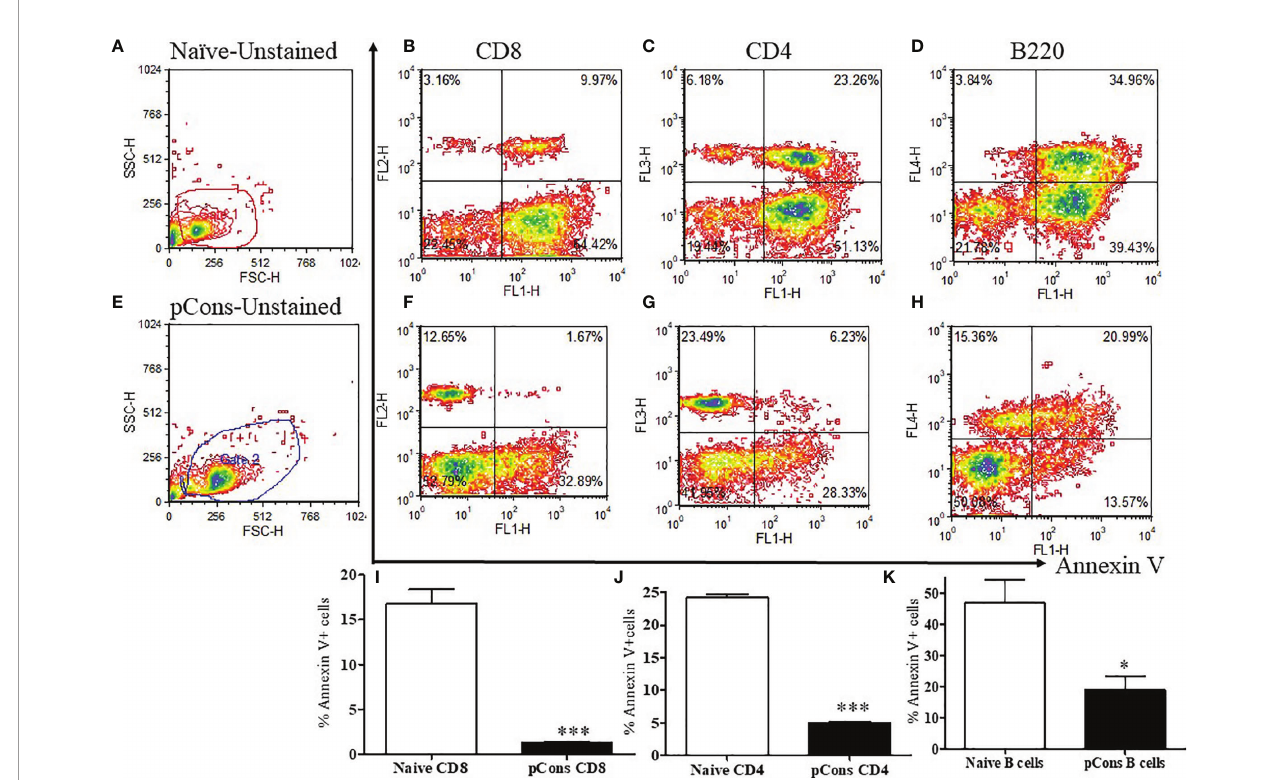
FIGURE 4 | pCons treatment alters and reduces apoptosis in both T and B cells of BWF1 mice. Female 10-12-wk old BWF1 mice were treated with pCons (1 mg i.v .). After one-two week treatment, splenocytes were obtained from both naïve and pCons-treated BWF1 mice (two/three mice in each group). RBC were lysed, cells washed, and stained with fl uorochrome-labeled speci fi c antibodies [CD4 (PerCP), CD8 (PE), B220 (APC), and Annexin V (FITC)] and fl ow cytometry performed. (A) Naïve unstained splenocytes; (B) Naïve CD8 + T cells; (C) Naïve CD4 + T cells; (D) Naïve B220 + B cells; (E) pCons-treated unstained splenocytes; (F) pCons- treated CD8 + T cells, (G) pCons-treated CD4 + T cells; (H) pCons-treated B220 + B cells; (I) Combined data of experiments (n=3-4) of naïve vs pCons-treated CD8 + Annexin V + T cells; (J) Combined data of experiments (n=3-4) of naïve vs pCons-treated CD4 + Annexin V + T cells; (K) Combined data of experiments (n=3-4) of naïve vs pCons-treated B220 + Annexin V + B cells. Minimum of 10,000 live cells were gated for data analyses. Dead cells were excluded from the analyses. Data was analyzed with FCS Express Ver. 7 ( De Novo , Ontario, Canada). Statistical differences were determined by paired two-tailed Student ’ s t-test. *p < 0.05, ***p <